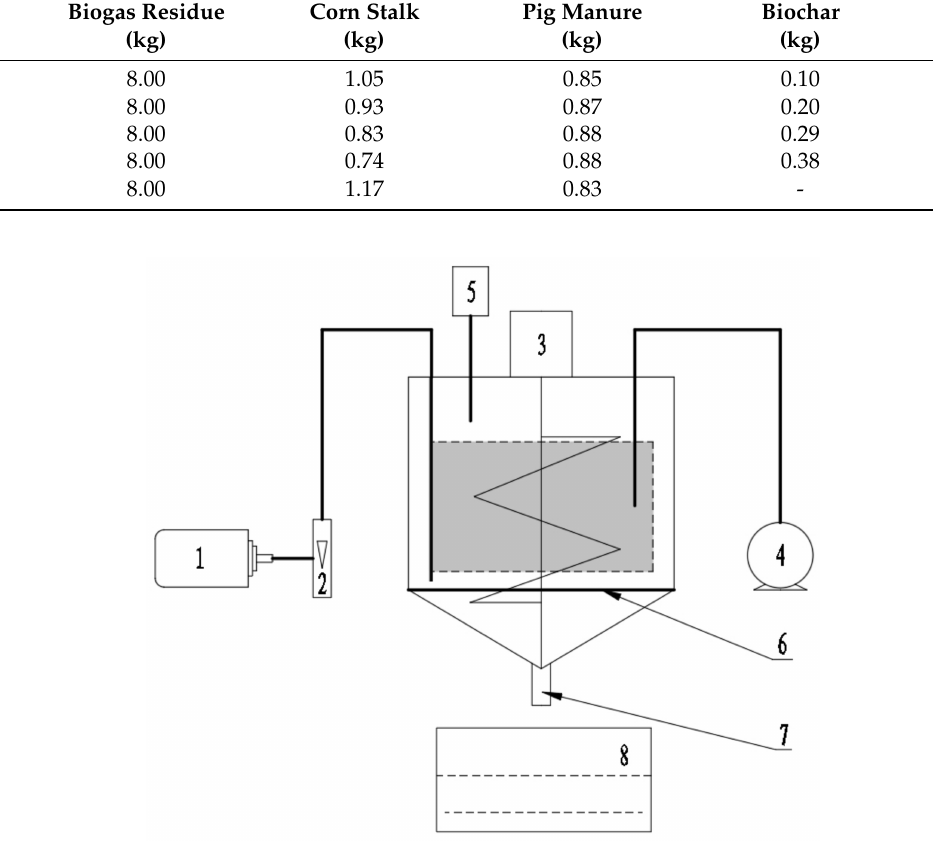
Figure 1. Schematic diagram of composting reactor. 1. Aeration fan, 2. gas flow meter, 3. stirring motor, 4. temperature monitoring, 5. gas collection, 6. sieve plate, 7. leachate outlet, 8. leachate